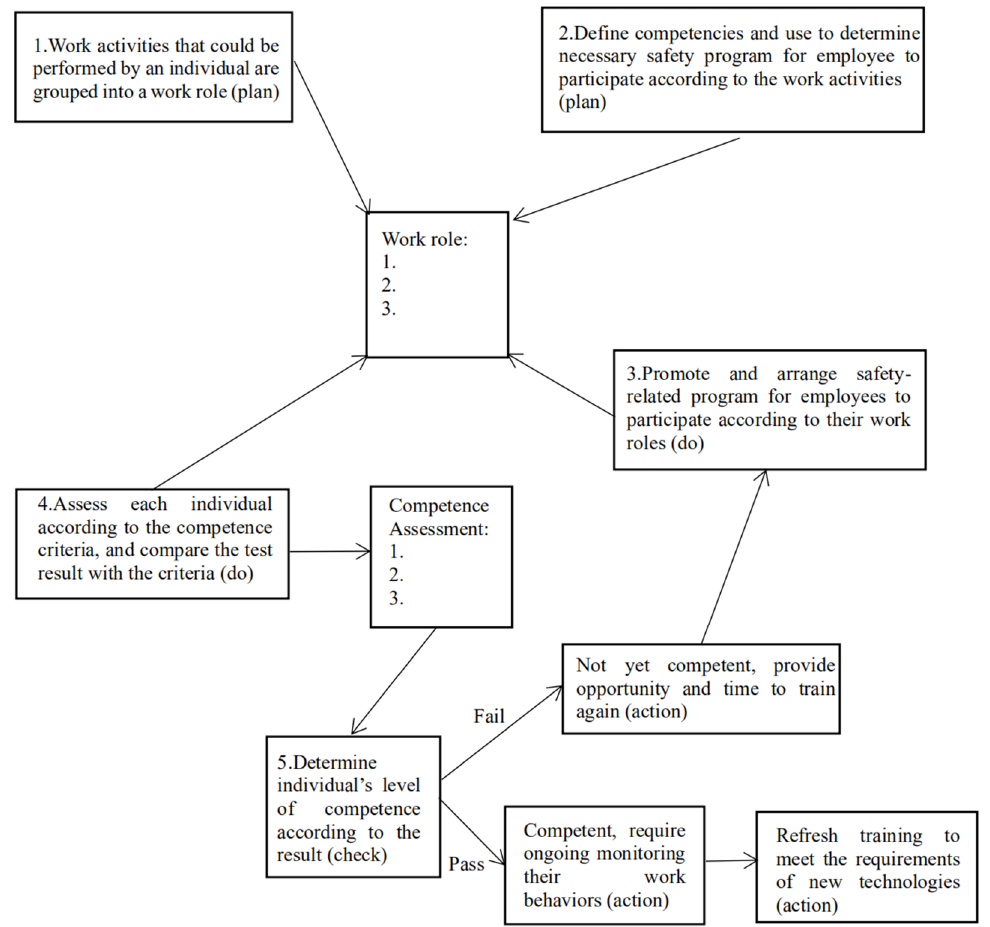
Figure 4. Refined management model based on this research.